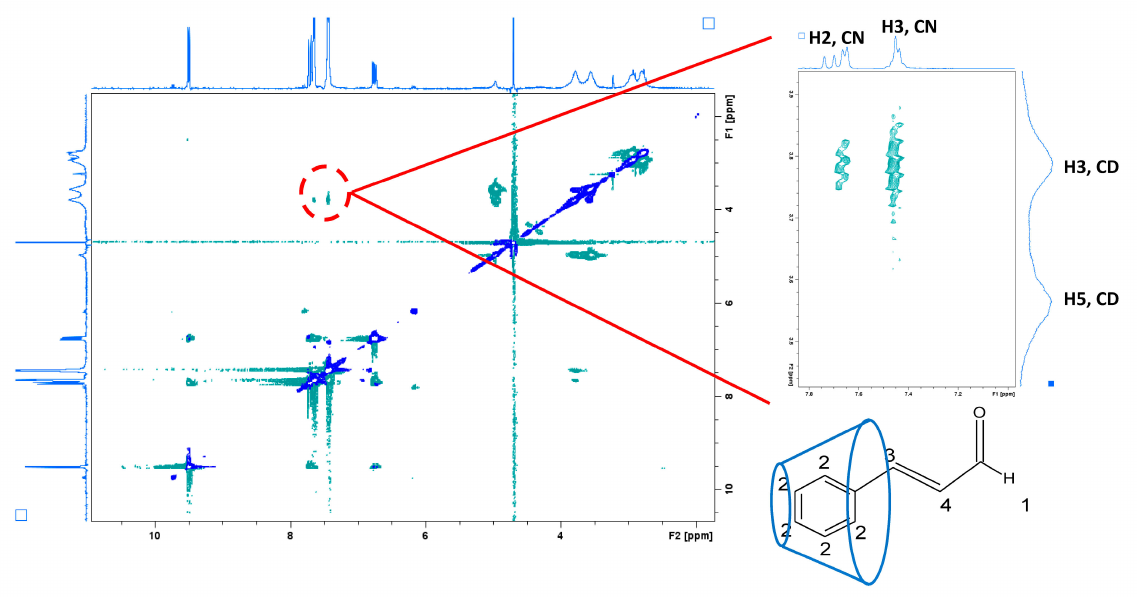
Figure 2. ROESY NMR spectra of the PCD:CN complex (1:1). A zoom focusing on the correlation signals (red circle) of CN (H2 and H3): PCD (H3 and H5) protons are visible beside it. Correlation signals indicate that the aromatic groups (H2) and H3 of CN are complexed by the cavity of CD, as proposed by the model.